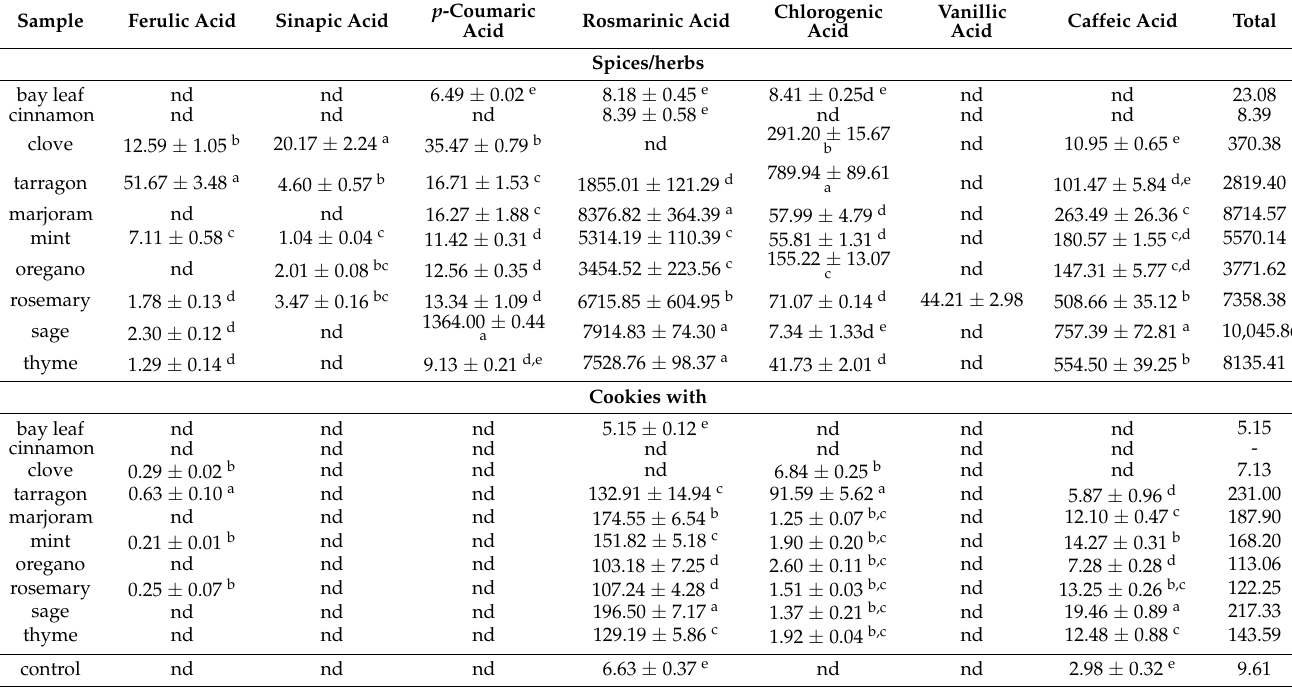
Table 1. Content of phenolic acids in 80% methanolic extracts of the analysed spices/herbs, and cookies with their contribution. The total content of phenolic compounds in each sample is presented in the last column of the table. Data presented as µ g/g of DM; nd—non